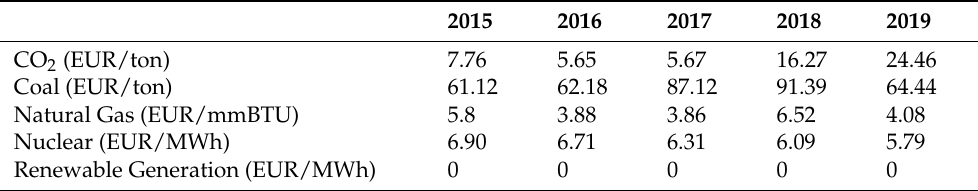
Table 1. Yearly average prices of CO 2 , coal, and natural gas for the period